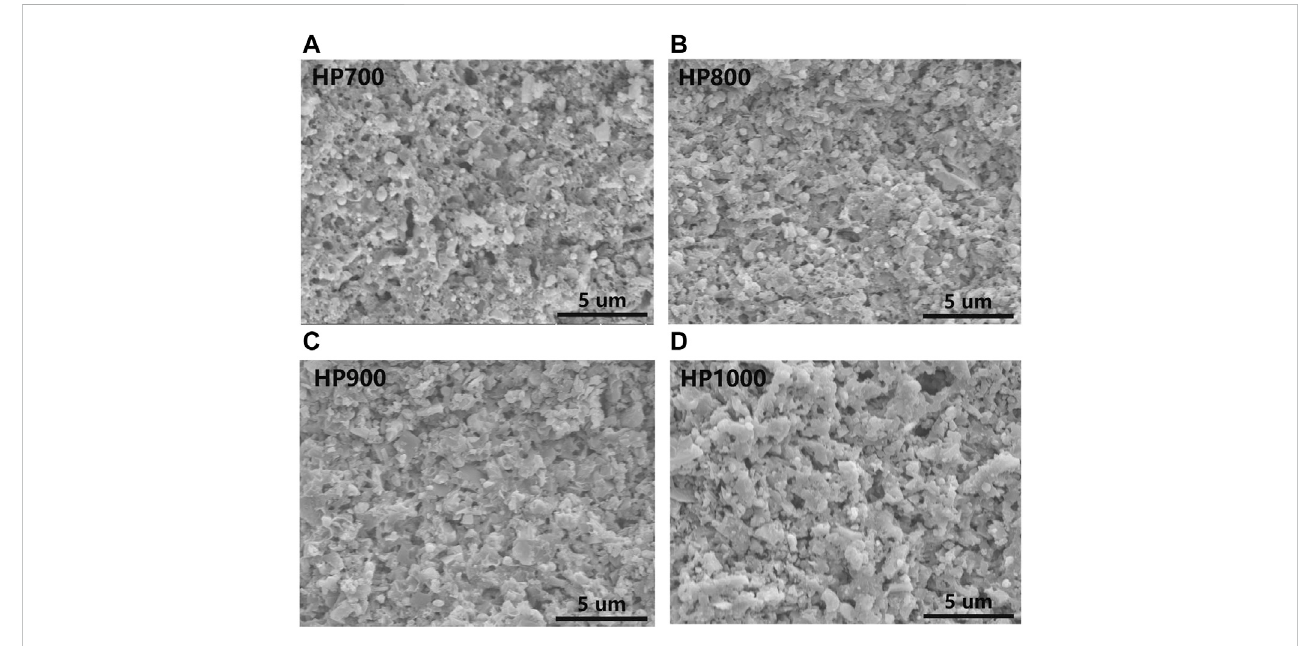
FIGURE 2 SEM images of SiC/BBSZA composites sintered at different temperatures: (A) 700 ° C, (B) 800 ° C, (C) 900 ° C, and (D) 1,000 °